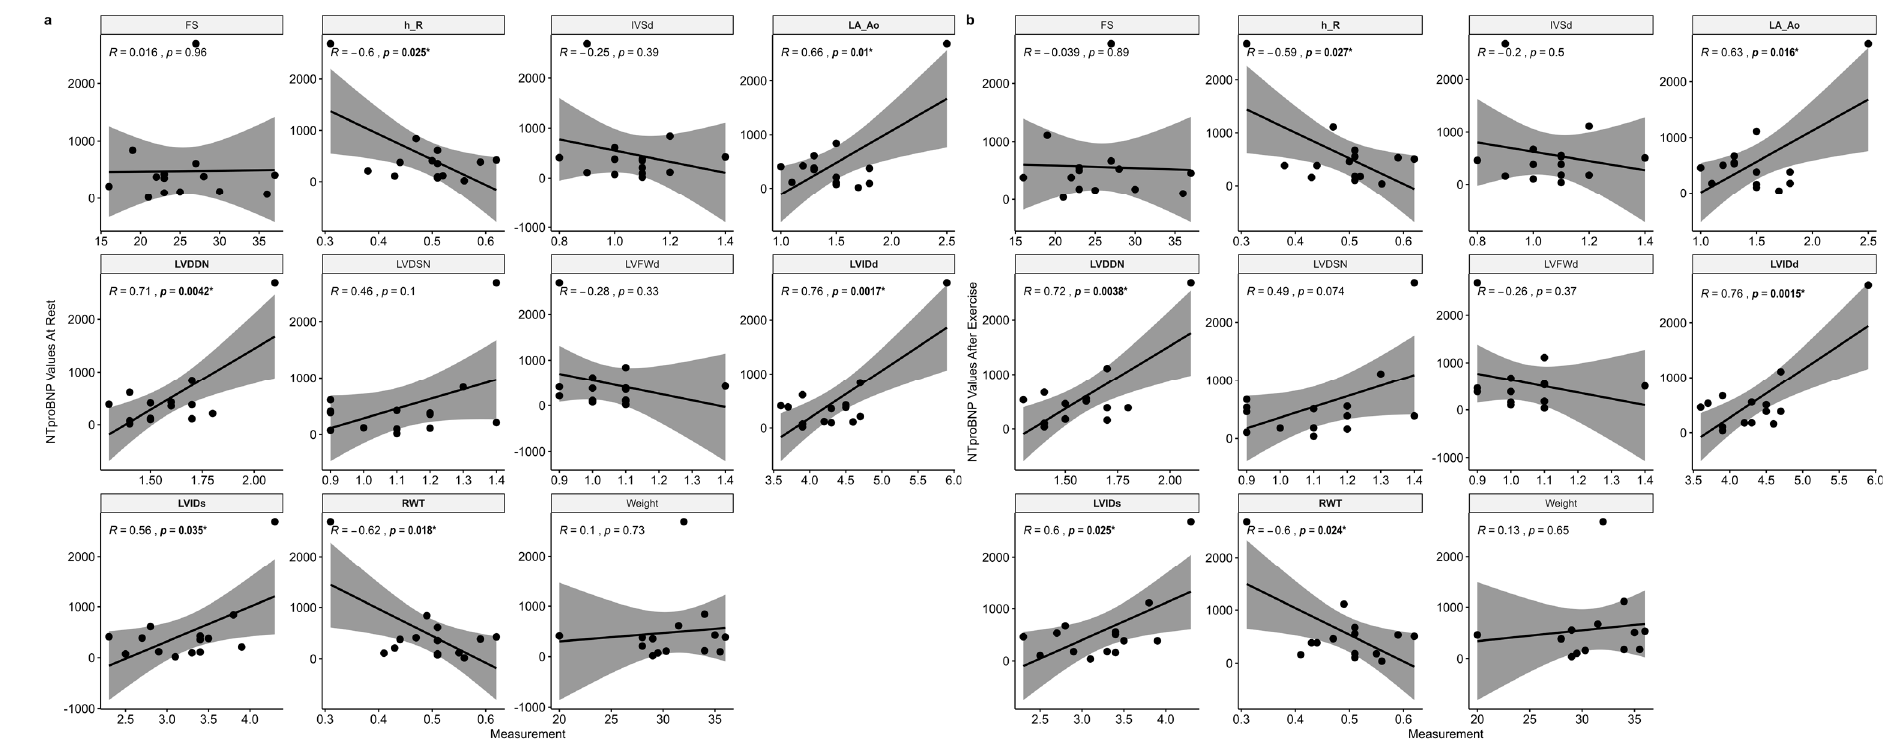
Figure 3. Correlation between echocardiographic parameters and NTproBNP values at rest ( a ) and after exercise ( b ). * Variables with significant associations.